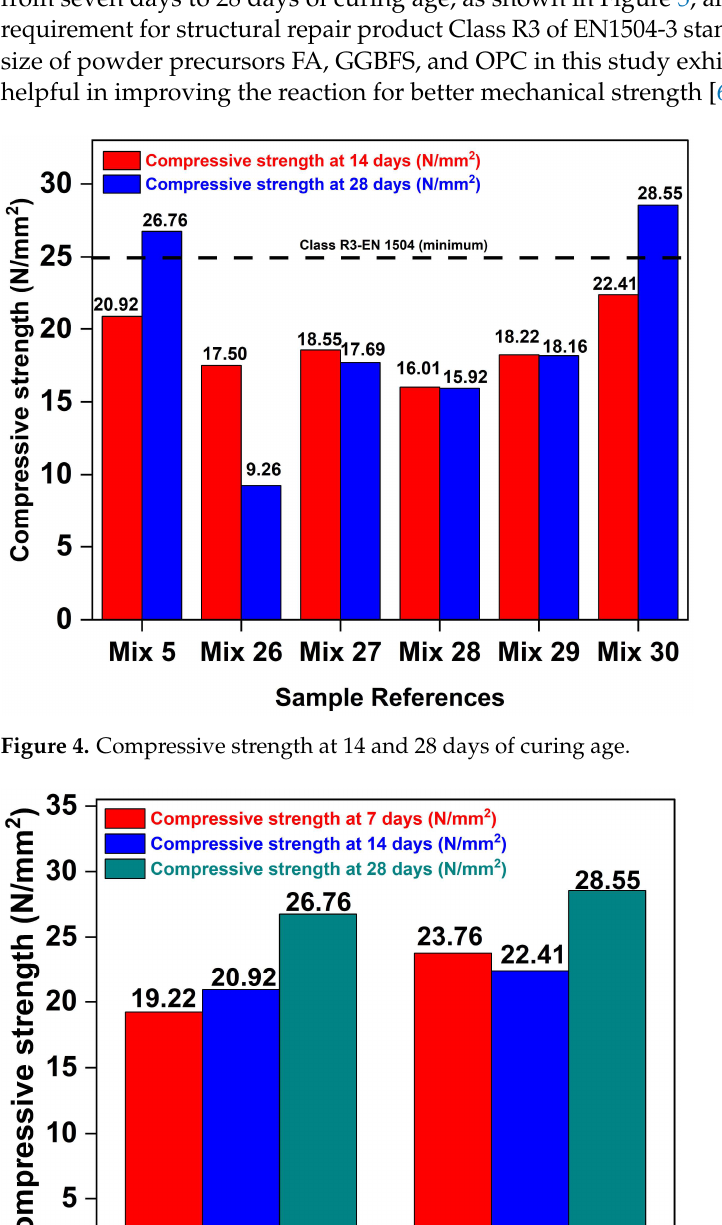
( b ) Figure 6. ( a ) Cracked pattern failure for mortar sample mix 30 under compressive strength test; ( b ) Cracked pattern failure for mortar sample mix 26 under compressive strength test.